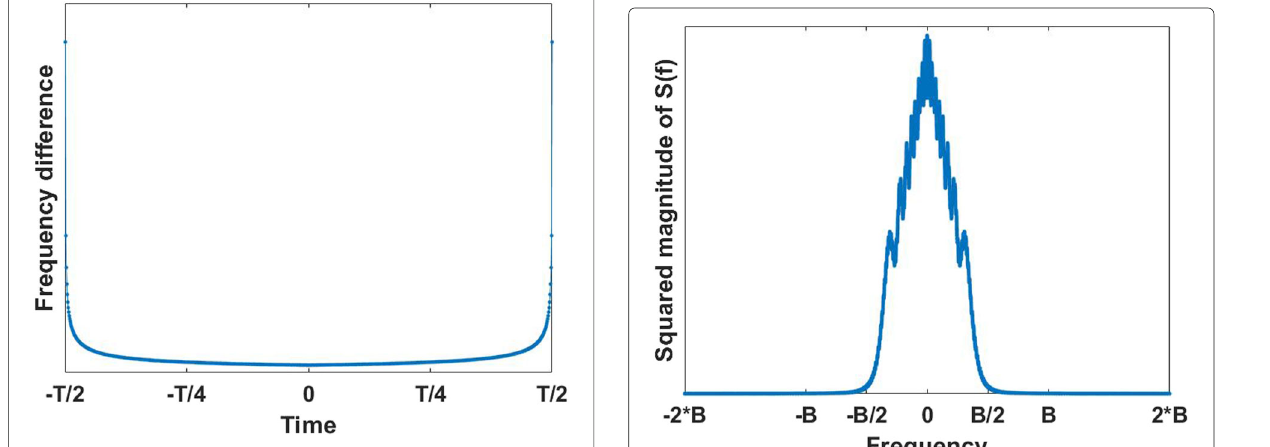
Fig. 2 First difference of frequency function which is proportional to the first derivative of the typical frequency function shown in Fig. 1. The derivative has large value near the start and stop of the signal which correspond to the frequency band edges and small value at the low frequencies (from baseband perspective). Hence, as per SPP, the signal spends small time at the band edges and more time at the center frequencies